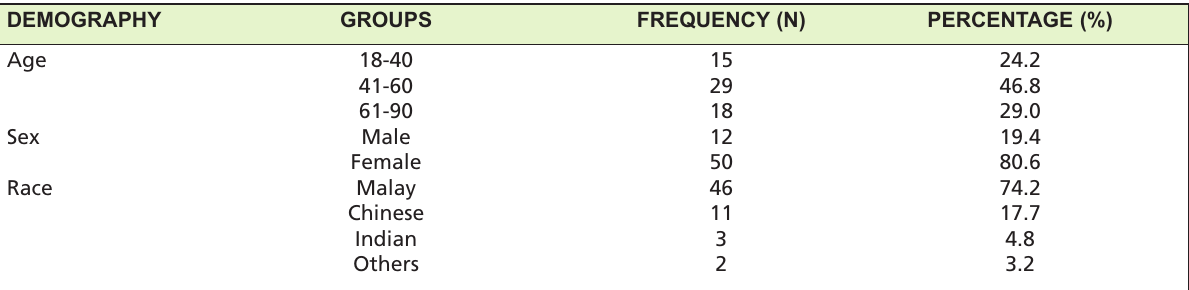
Demographic characteristics of CTS patients Table I: